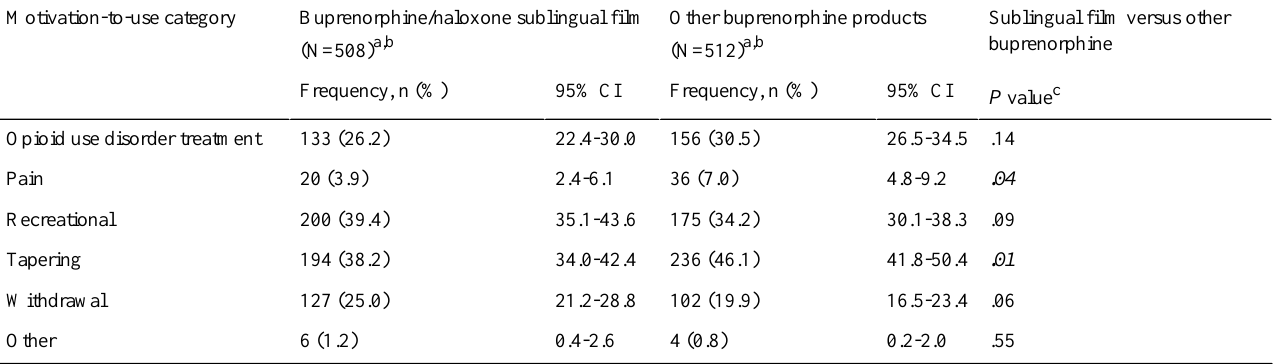
Table 5. Percentage of posts mentioning specific motivation-to-use categories and Chi-square P values for pairwise differences in buprenorphine/naloxone sublingual film versus other buprenorphine